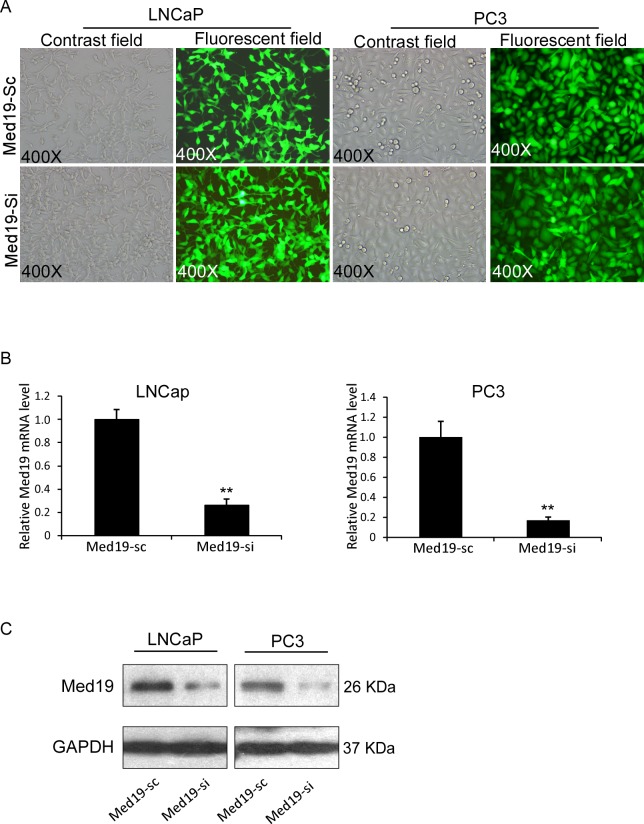
Establishment and characterization of LNCaP-Med19-si/sc and PC3-Med19-si/sc cells.(A) After lentivirus infection and FACS sorting, the transduction efficiency was confirmed by determining the GFP expression in a fluorescent microscope. The GFP positive rate was more than 95% in all cells. (B) In Q-PCR assay, the relative Med19 expression levels were 26.18±5.27% in LNCaP-Med19-si cells (n = 3, **P<0.01), and 16.88±3.40% in PC3-Med19-si cells (n = 3, **P<0.01). (C) In Western blot assay, the Med19 expression level was dramatically decreased in LNCaP-Med19-si and PC3-Med19-si cells. GAPDH was used as an internal control.